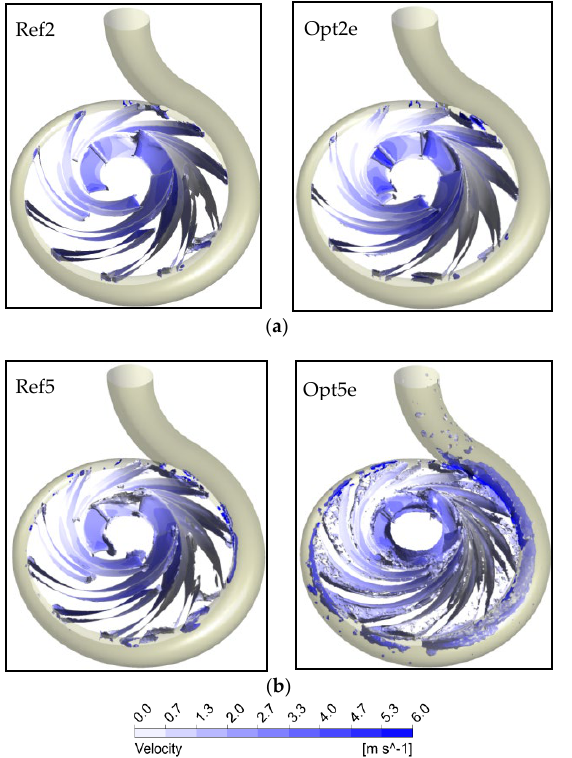
Figure 22. Velocity at the vortex core region of the reference and optimized impeller: ( a ) C1 and ( b ) C4.